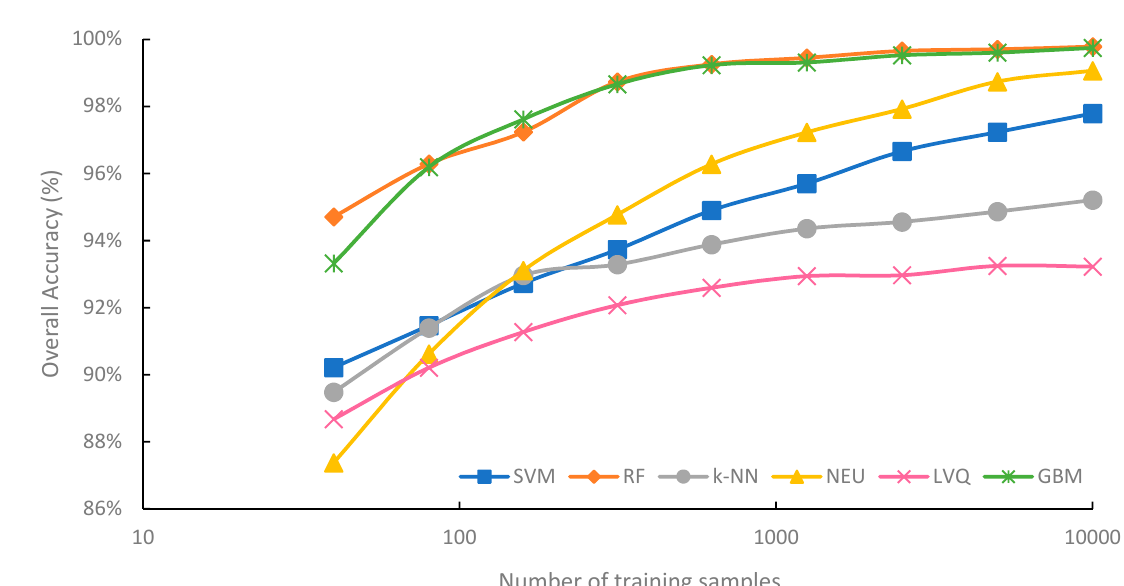
Figure 3. Mean overall accuracy of supervised classifications and training set size. Please note that the x-axis is on a log scale.